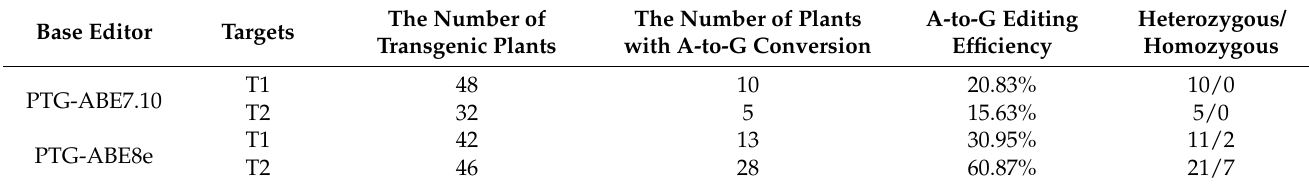
Table 1. Editing efficiencies induced by ABE8e and ABE7.10 in transgenic plants.